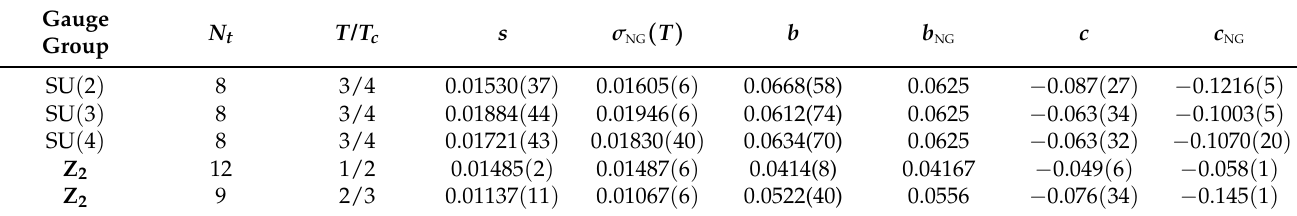
Table 2. Results of the fits to Q ( R , T ) for various LGTs (listed in the first column), together with the expected values for the best fit parameters according to the Nambu–Goto